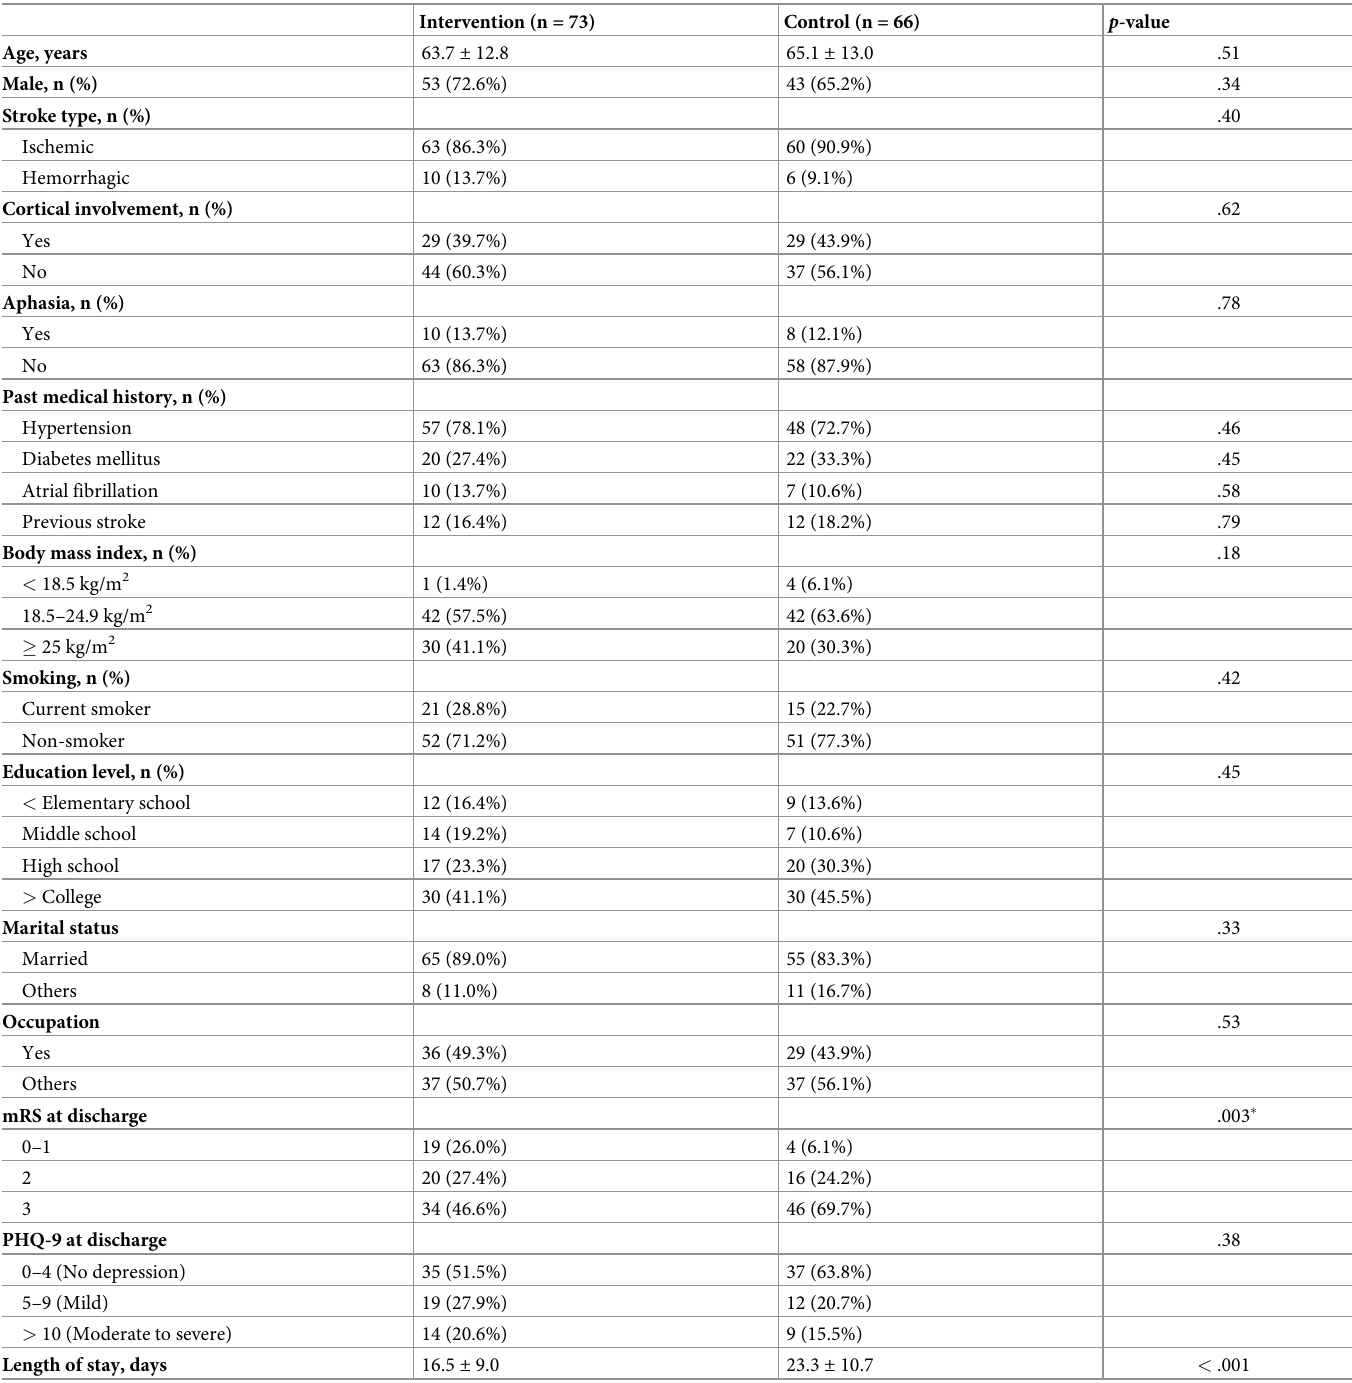
Table 1. Comparison of the baseline